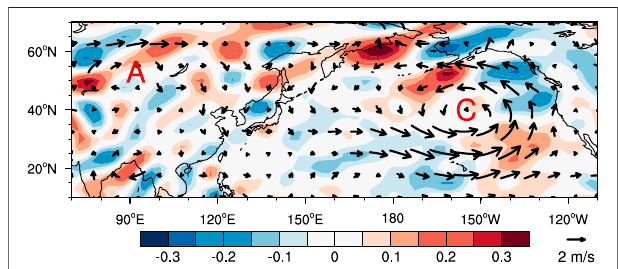
FIGURE 7 | Regression of the winter wind at 850 hPa (vector; units: m · s − 1 · K − 1 ) and divergence (shading, units: 10 − 5 s − 1 · K − 1 ) on the PDO. The letters A or C sign centre of anomalous anticyclone or cyclone, respectively. FIGURE 8 | The winter ANH index (black dash line) from 1979 to 2018. The fi lling curve is the 5-year running averaged values (red and blue